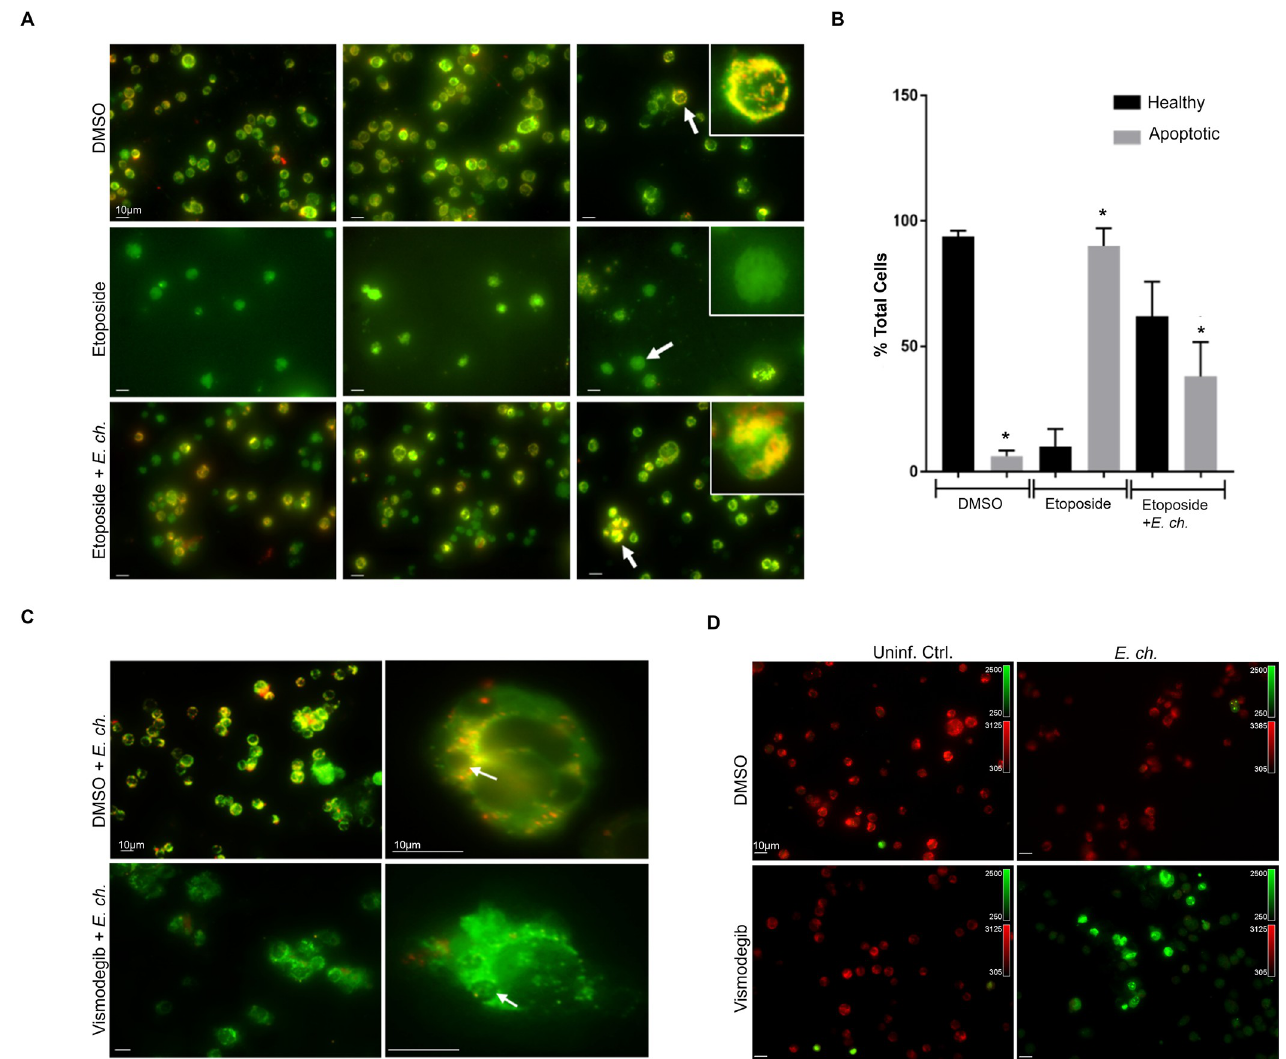
Fig 11. E . chaffeensis mediated activation of Hh signaling inhibits host cell apoptosis. (A) Immunofluorescence analysis of uninfected and E . chaffeensis- infected THP-1 cells stained with JC-1 dye after treatment with 100 μ M of Etoposide or DMSO control. The micrographs demonstrate the formation of JC aggregates (orange; 590 ± 17.5 nm) in mitochondria with positive membrane potential in DMSO treated cells (top panel). Due to depolarization of the mitochondrial membrane in Etoposide-treated cells, JC-1 remains as a monomer and yields green fluorescence with the emission of 530 ± 15 nm (middle). E . chaffeensis- infected (MOI 100) Etoposide-treated THP-1 cells showed increased cells with JC-1 aggregates, indicating active inhibition of host cell apoptosis during E . chaffeensis infection (bottom). (B) Bar graph depicts percentage of normal or apoptotic cells in DMSO, Etoposide, or Etoposide + E . chaffeensis groups. Percent of total cells were counted from randomized areas/slide (n = 10). There were significantly fewer apoptotic cells in DMSO and Etoposide + E . chaffeensis groups, but significantly more apoptotic cells in Etoposide treated groups. Experiments were performed in biological and technical replicates and significance was determined through t -test analysis. Data are represented as means ± SD ( � p < 0.05). (C) Immunofluorescence analysis of mitochondrial membrane potential using JC-1 dye in E . chaffeensis- infected (MOI 100) THP-1 cells treated with Hh inhibitor Vismodegib or DMSO. The micrograph demonstrated the presence of mitochondria with positive membrane potential in DMSO treated infected THP-1 cells compared to Vismodegib-treated infected (MOI 100) THP-1 cells. Arrow points to the ehrlichial inclusion. (D) Immunofluorescence analysis of uninfected and E . chaffeensis- infected (MOI 100) THP-1 cells stained with Nucview488 and the Mitoview633 Dye after treatment with Vismodegib or DMSO control. The micrographs show Nucview488 dye is cleaved by caspase 3 and produces green fluorescence in Vsmodegib-treated E . chaffeensis- infected cells due to the activation of apoptosis. In comparison, due to positive mitochondrial membrane potential, Mitoview633 accumulated in the inner mitochondrial membrane (red) in Vismodegib- uninfected and DMSO treated (Ctrl) uninfected and infected cells. These results demonstrate that Hh signaling plays a crucial role during E . chaffeensis infection by inhibiting intrinsic death signaling. (A, C, D) Experiments were performed with at least three biological and technical replicates. Randomized areas/slide (n = 10) were selected to visualize the phenomenon. Scale bar = 10 μ m.